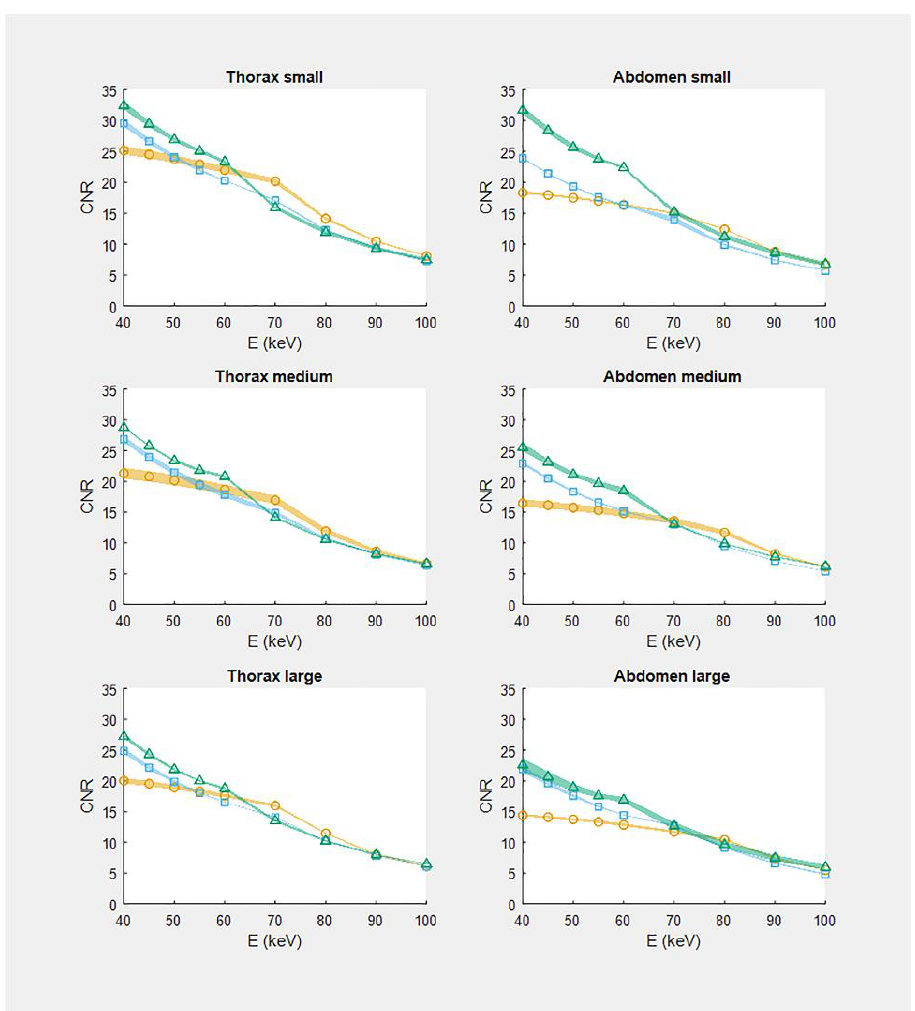
Figure 2. CNR in virtual monoenergetic images reconstructed without iterative reconstruction technique as a function of energy E (keV). For each phantom, CNR is presented for both the EID and PCD-based system. Circles: dual-source EID-based dual-energy; squares: single-energy 120 kVp PCD-CT; triangles: single-energy 90 kVp PCD-CT. Symbols depict the mean of three measurements and the accompanying shaded boundaries depict the standard error of the mean. Table 2. Contrast-to-noise-ratios for virtual monoenergetic images at 40 keV of an energy integrat- ing detector (EID) and a photon-counting detector (PCD)-based CT system. Iterative reconstruction technique was turned off.